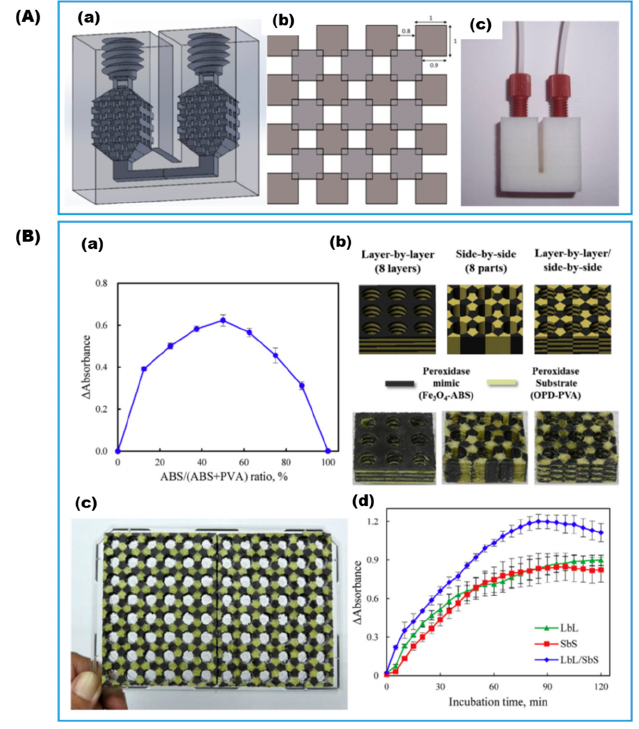
Figure 2. ( A ) ABS-based flow reactor: ( a ) CAD drawings, ( b ) ordered cuboids pattern in the reaction chamber, and ( c ) photo of the printed reactor (Reproduced with permission from Ref. [20]); ( B ) multi-material substrate-impregnated micro-titer plate for glucose determination: ( a ) effect of ratio of GOx, peroxides mimic, and substrate on signals as varied by different 3D patterns, ( b ) CAD drawings and photos of plates with different material stacking pattern, ( c ) photo of two printed 48-well plates fitting to a regular 96-well plate frame, and ( d ) effect of 3D pattern on the kinetic signals (Reproduced with permission from Ref. [22]).